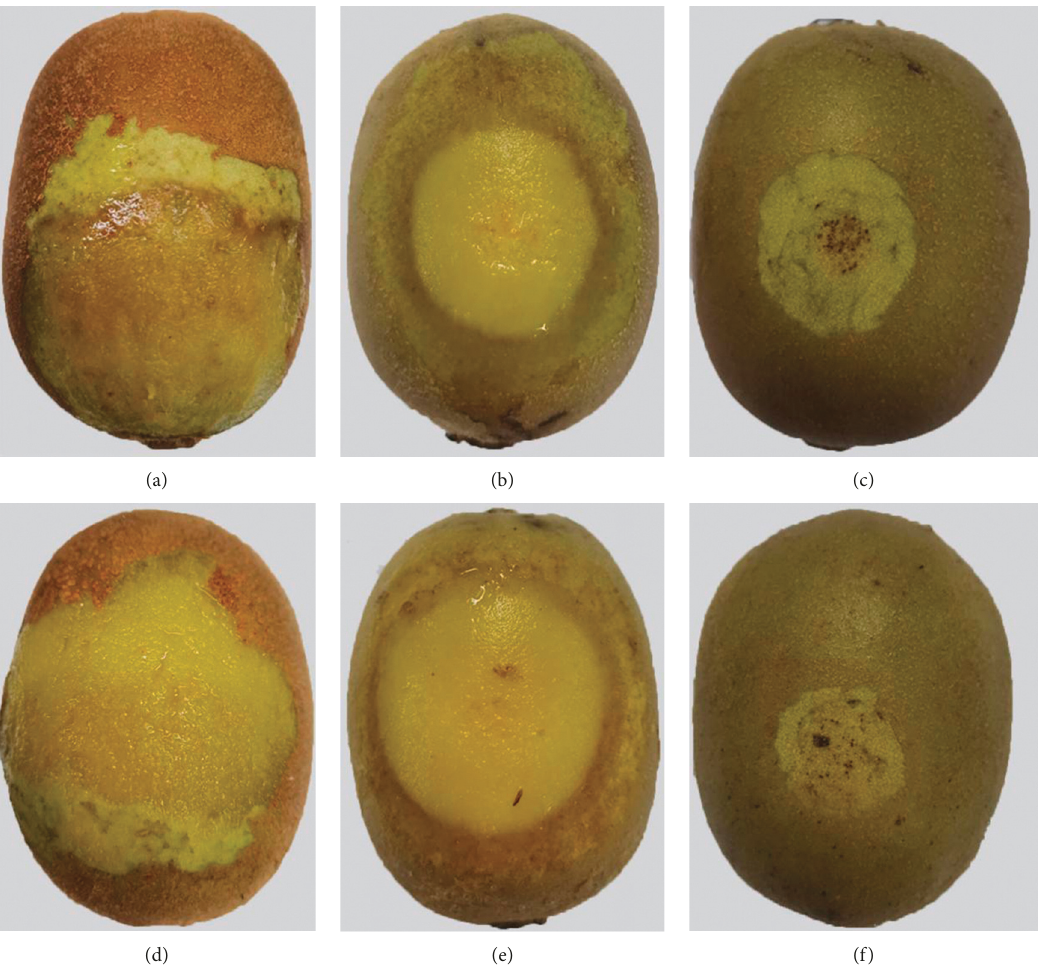
Figure 4: The symptoms of F1 and F2 strains in the pathogenicity test. (a)-(b) The pathogenicity test by F1 strain. (c) CK group for strain F1. (d)-(e) Pathogenicity test by F2 strain. (f) CK group for strain F2.